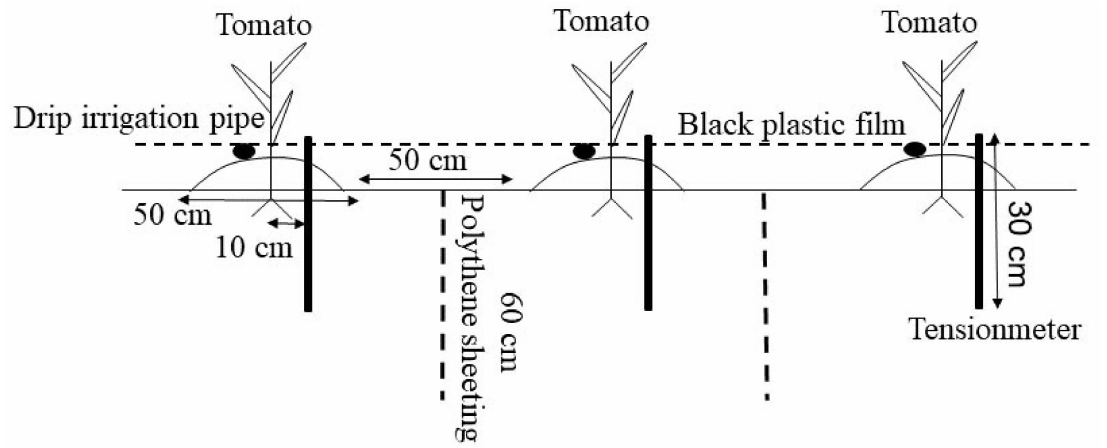
Figure 1. Profile of the tomato planting